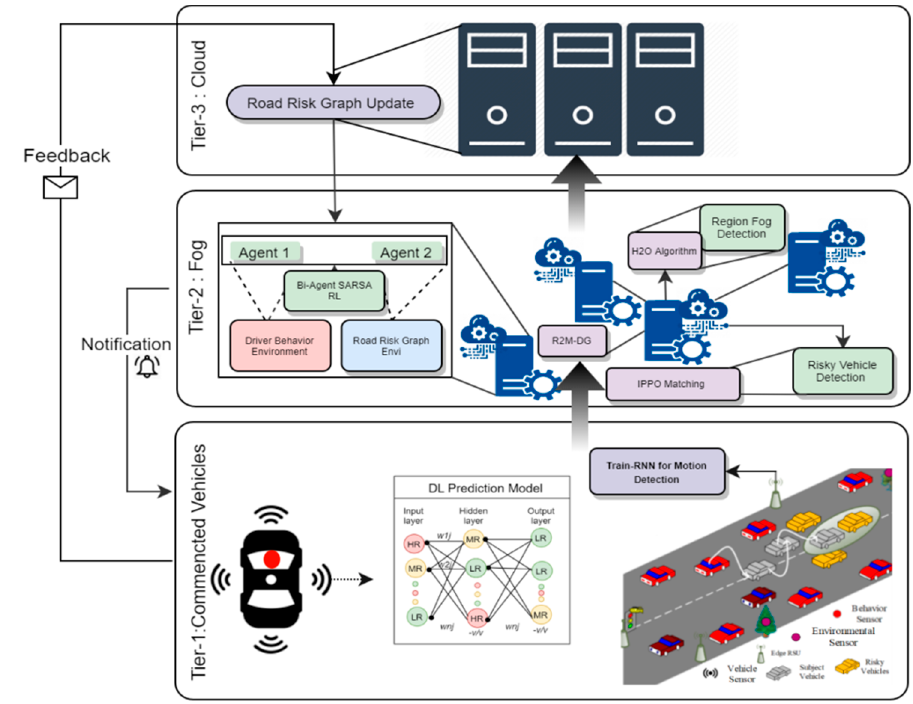
Figure 2. SafeDrive architecture for three-tier alert system.